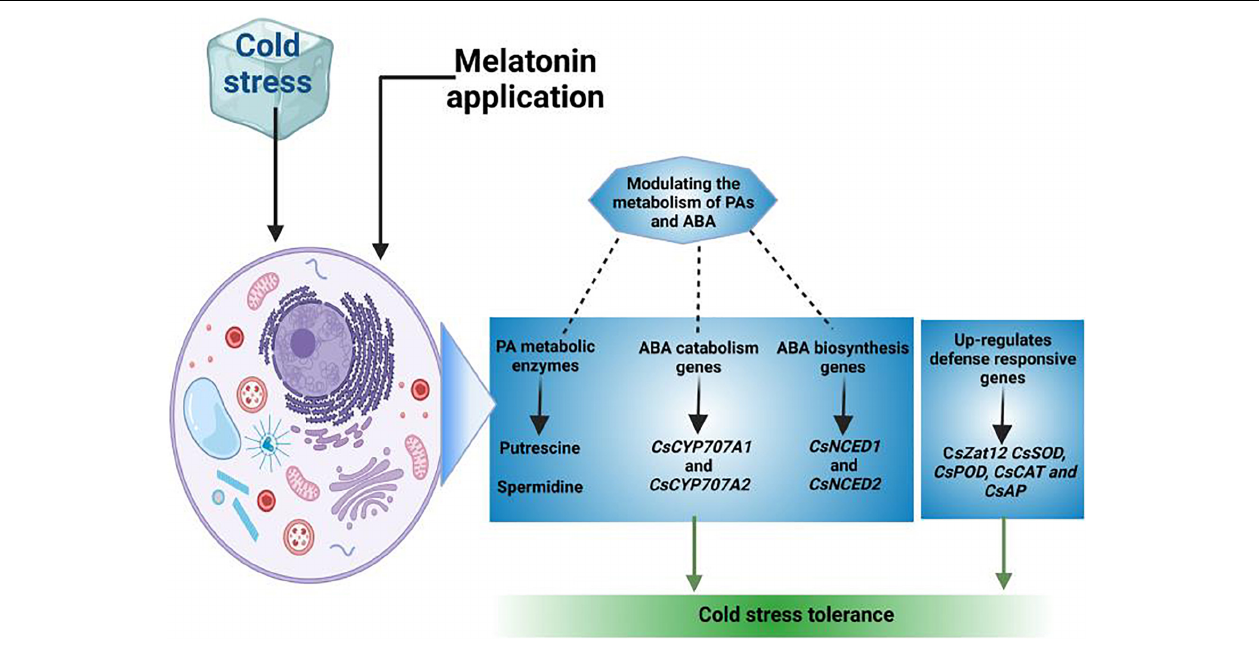
FIGURE 4 | A proposed model of MT medicated polyamines accumulation for improving cold tolerance in plants. MT application upregulates genes expression linked with polyamines accumulation and genes linked with ABA synthesis and ABA catabolism. The application of MT improves polyamines accumulation and increase the genes expression to for catabolism of ABA and resulting in significant improvement in photosynthetic efficiency and cold tolerance in plants.